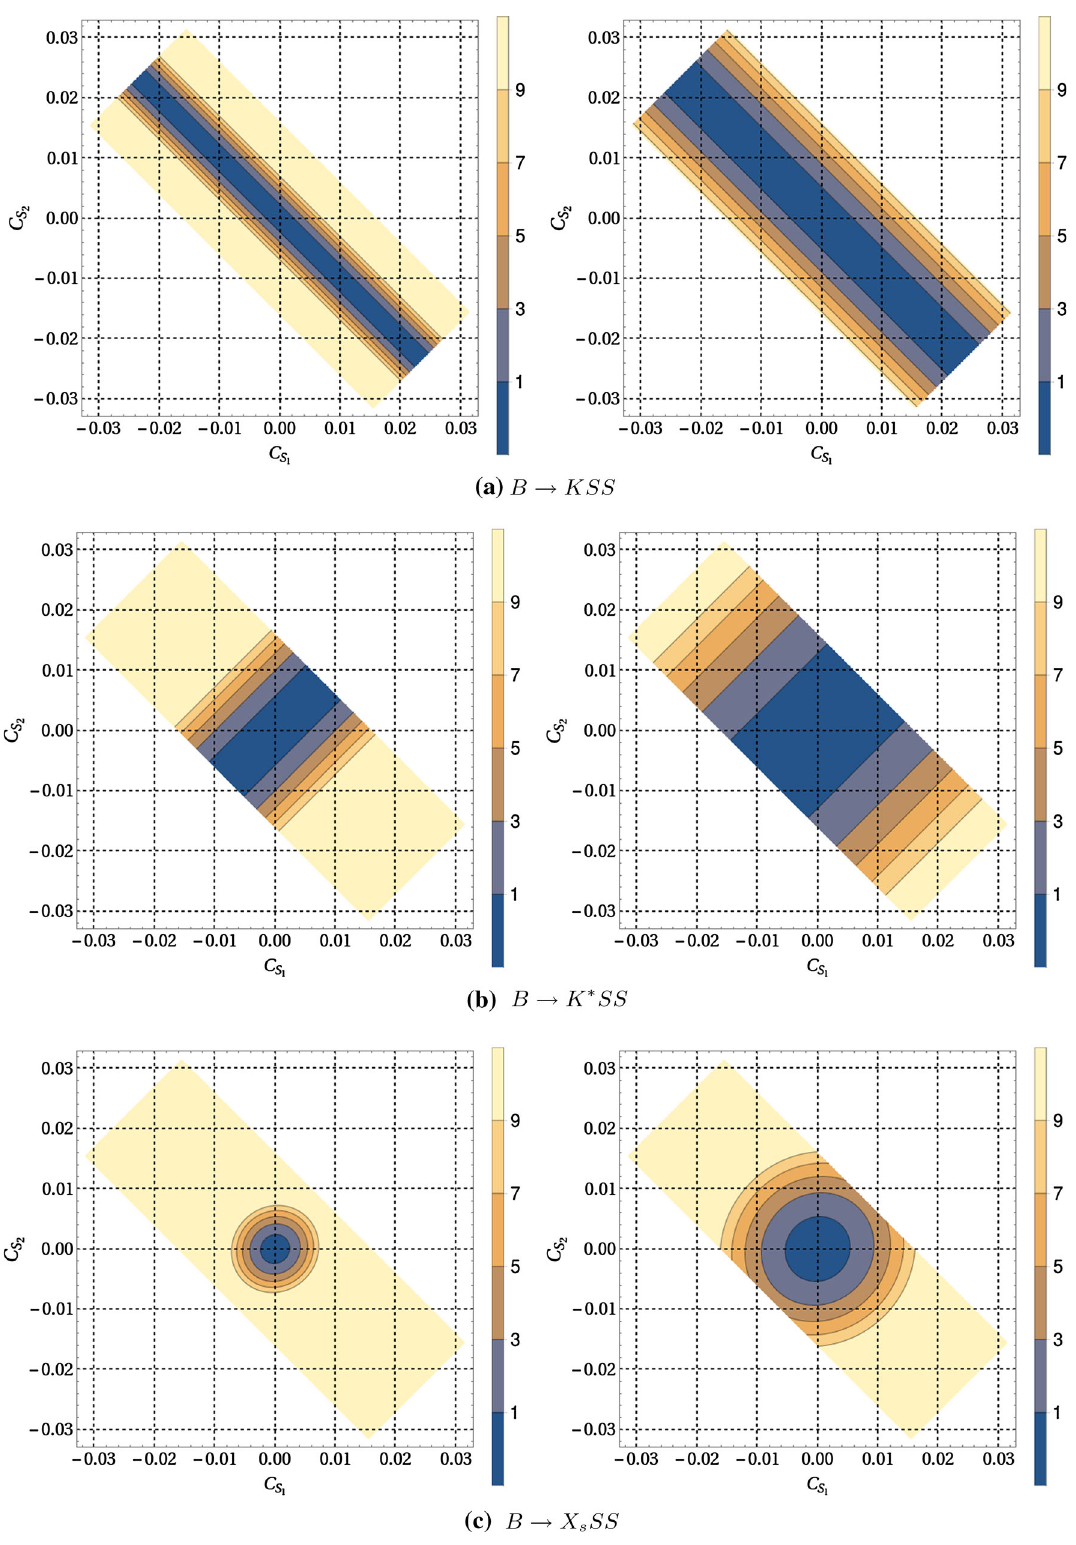
Fig. 5 The differentiation contours for b → sSS with m S = 0 . 5 GeV and L int = 50ab − 1 (left panels), 2 ab − 1 (right panels). We take Λ = 1